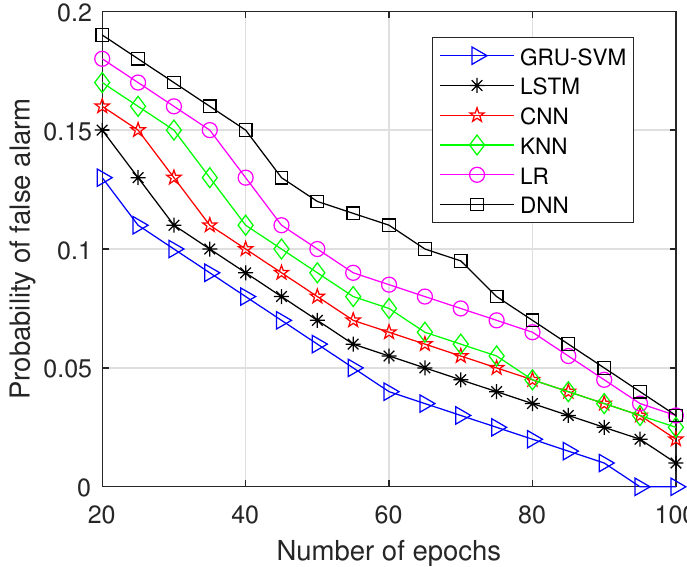
Figure 10. Probability of false alarm vs. Number of Epochs. The confusion matrix for the training phase and testing phase for the normal case and under attack case is explained in Figures 11 and 12. The Confusion Matrix is a performance measurement for two class classification. It is a table with four separate sets of actual and predicted values. In our paper, we classify authorized and malicious ones.